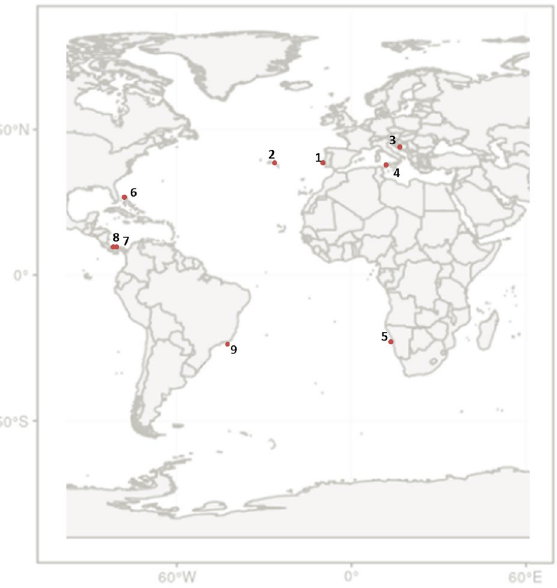
Figure 2. Geographic location of sampling sites. 1—Northeast Atlantic (Sado estuary, Portugal), 2—Mid- North Atlantic (Azores, Portugal), 3—Adriatic Sea (Cres-Lošinj, Croatia), 4—Central Mediterranean Sea (Sicily Channel, Italy), 5—Southeast Atlantic (Walvis Bay, Namibia), 6—Caribbean Sea (Bahamas), 7—West Central Atlantic (Bocas del Toro, Panama), 8—West Central Atlantic (Gandoca-Manzanillo, Costa Rica), 9—Southwest Atlantic (Rio de Janeiro coast,